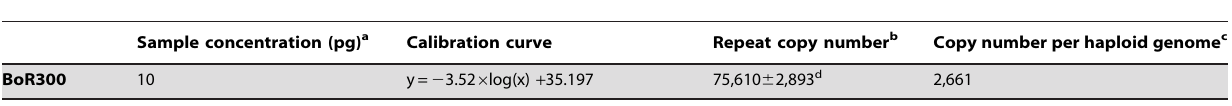
Table 3. qPCR analysis data of the relative estimation of BoR300 repeats using a reference standard curve.